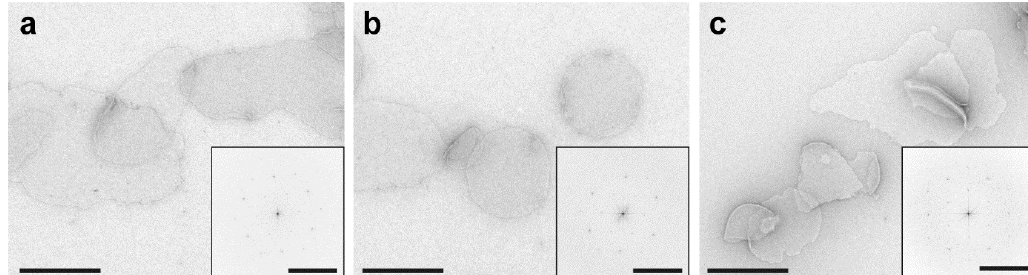
Figure 5. Structural characterization of purple membranes by negative stain transmission electron microscopy. Electron micrographs of negatively stained purple membrane patches containing BR-wt ( a ), BR-C-His 10 ( b ) and BR-D96N-C-His 10 ( c ). Insets show the power spectra of selected areas at higher magnification and demonstrate the crystallinity of the membrane patches. Scale bars represent 500 Å and 50 Å − 1 in the insets.